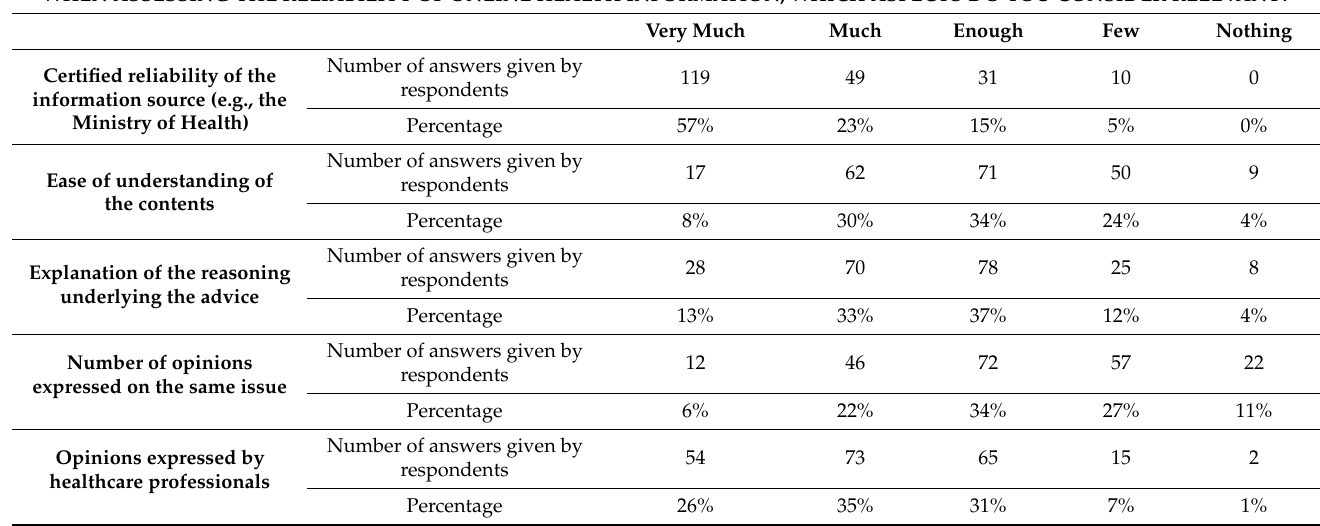
Table 9. Aspects to assess the reliability of the online health information.